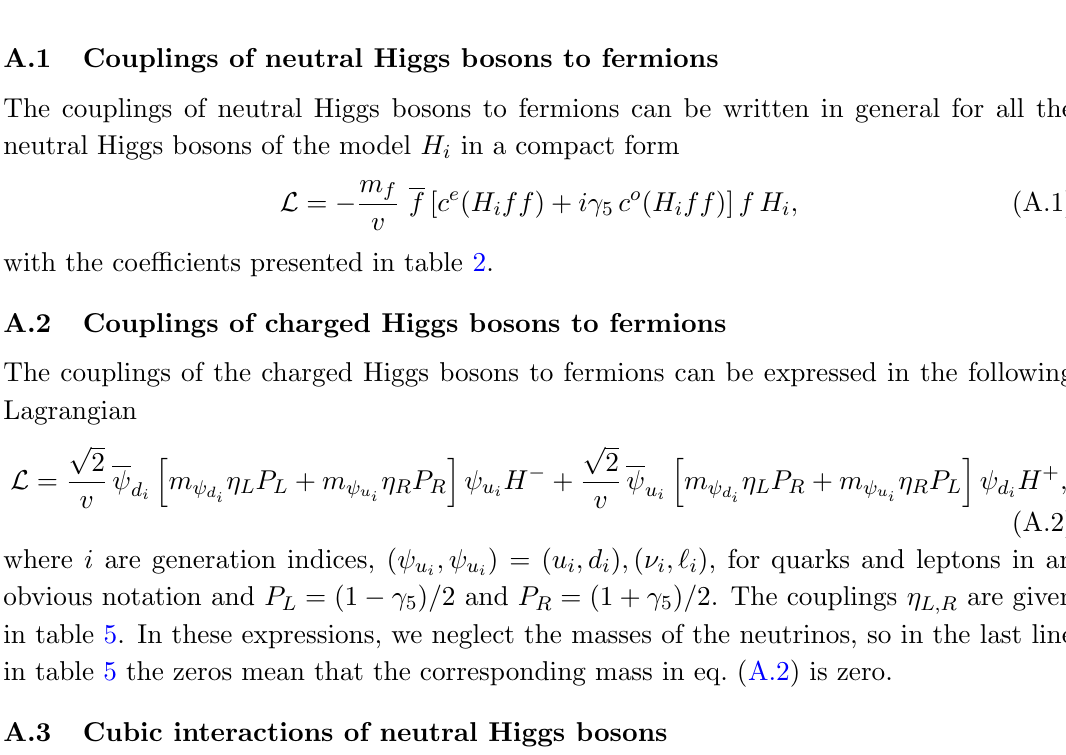
Table 5 . Couplings of the charged Higgs bosons to